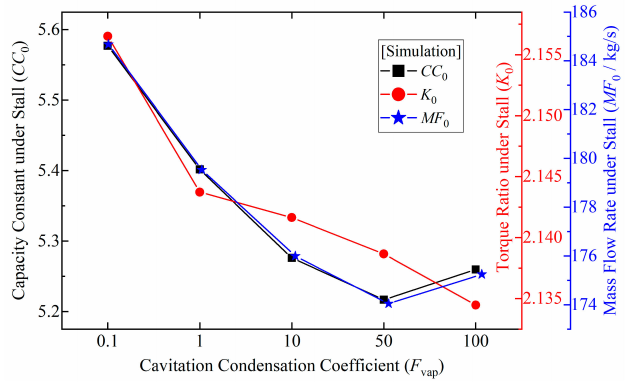
Figure 18. Capacity constant, torque ratio, and mass flow rate of torque converter at stall under various cavitation vaporization coefficients.